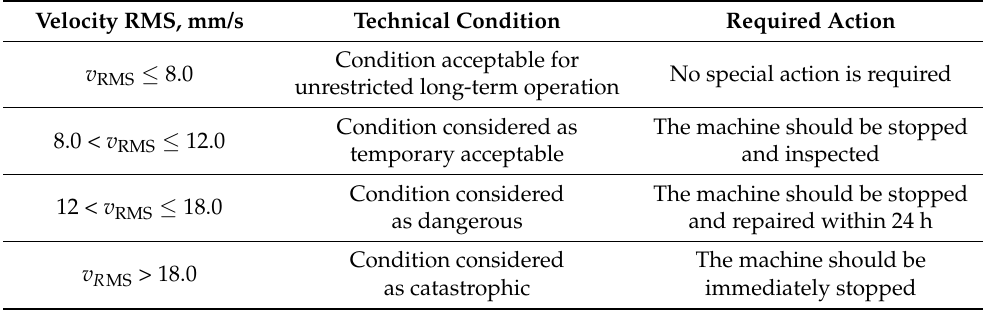
Table 2. Modified criteria for the assessment of the technical condition of industrial drive units with gears